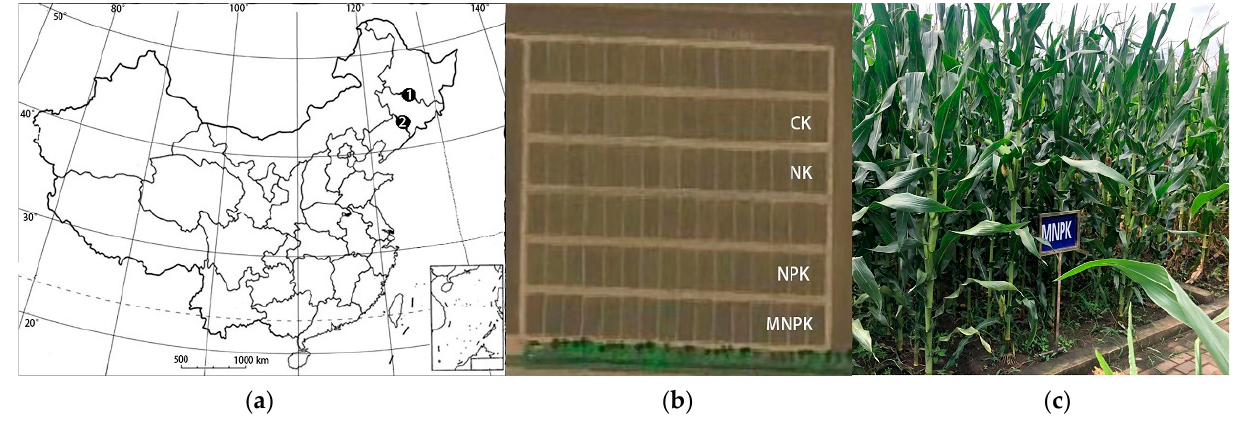
Figure 1. Approximate distribution map of experiments and fertilization treatment. 1 represents HRB, 2 represents GZL. ( a ): Location, ( b ): Trial design, ( c ): Field view. Table 1. Soil type, geographical location and climate in the two experiments.